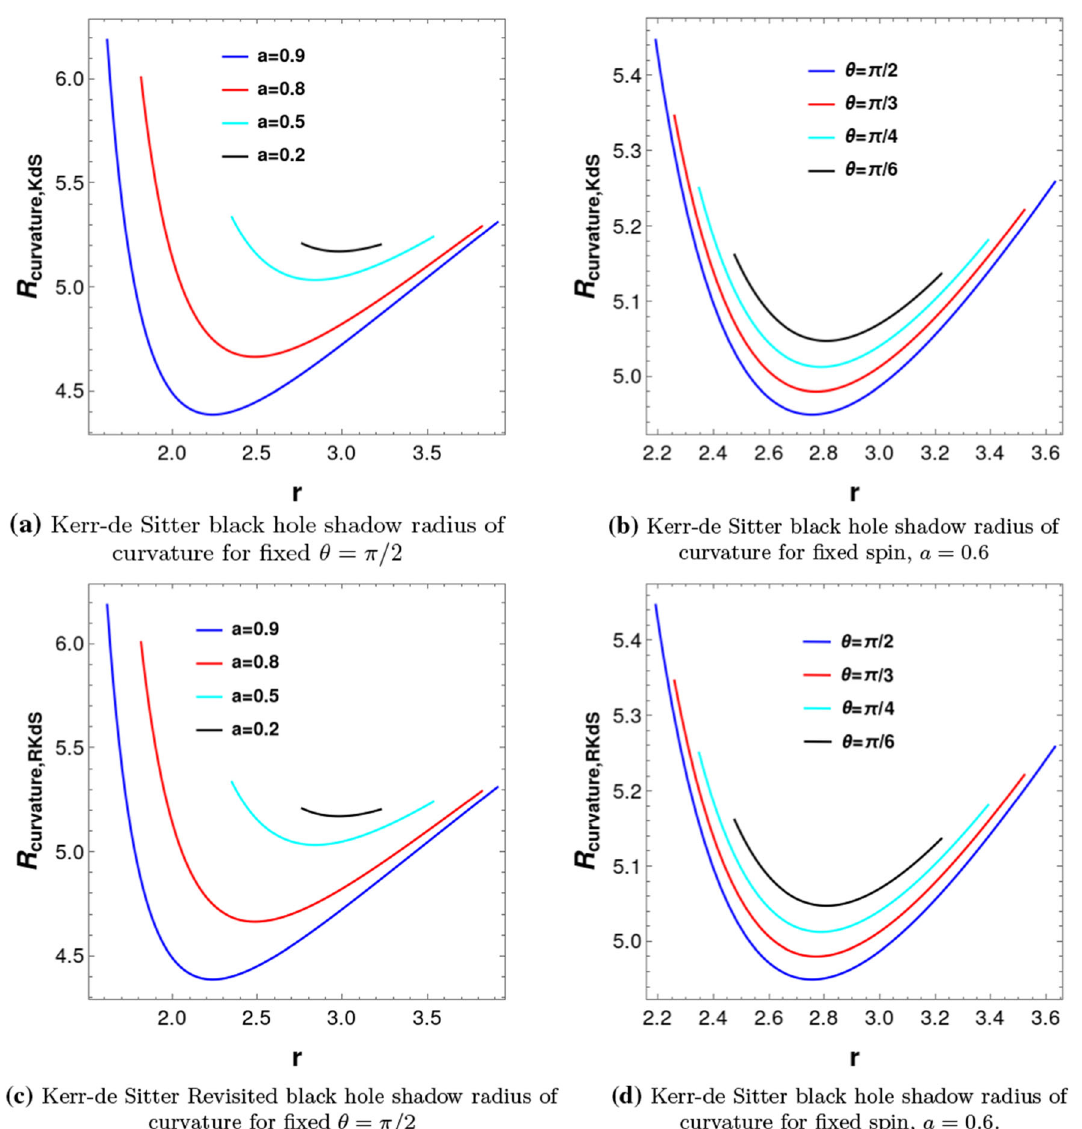
Fig. 10 Radius of curvature for Kerr-de Sitter and Kerr-de Sitter Revisited black hole shadow as a function of r . (cid:2) = 1 . 11 × 10 − 52 m − 2 and r ∈ [ r A , r B ] is such that ∂ r β = 0 Fig. 11 Region plots for the radius of curvature, (cid:2) = 1 . 11 × 10 − 52 m − 2 . The shaded parts indicate regions where the minimum radius of curvature is less than 4 . 31 M and the maximum curvature is greater than 6 . 08 M . Such regions according to Eq. (70) are excluded from observations by M87* hence imposing constraints on θ and a . The unshaded part is the allowed